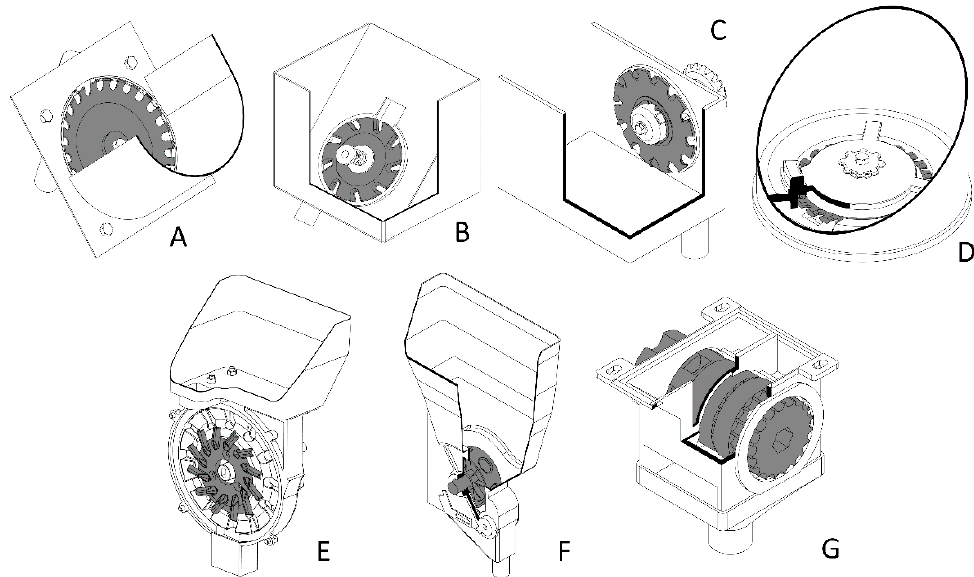
Figure 2. Model representations of the mechanical maize seed meters types evaluated, with ( A ) inclined plate systems with 24 seed orifices for the National Agro Industries, India (NAT), Sembradoras TIMS, Mexico (TIMS) and one of the Bangladesh Agricultural Research Institute meters (BARI-24), ( B ) inclined plate metering device with 9 orifices from Bangladesh (BARI-9), ( C ) vertical plate meter with 12 seed cups for the versatile multi-crop planter seed meter used in Nepal and Bangladesh (VMP-12), ( D ) horizontal plate meters with 24 orifices for the meters from Sembradoras del Bajio MR in Mexico (SDB) and Fitarelli in Brazil (FIT), ( E ) vertical plate system with 12 fingers representing a generic metering device from China (SRK), ( F ) roller system with 9 cells depicting the mechanism from Terradonis ® company in France (TER), and ( G ) a generic sliding fluted roller type metering system (2BGF).